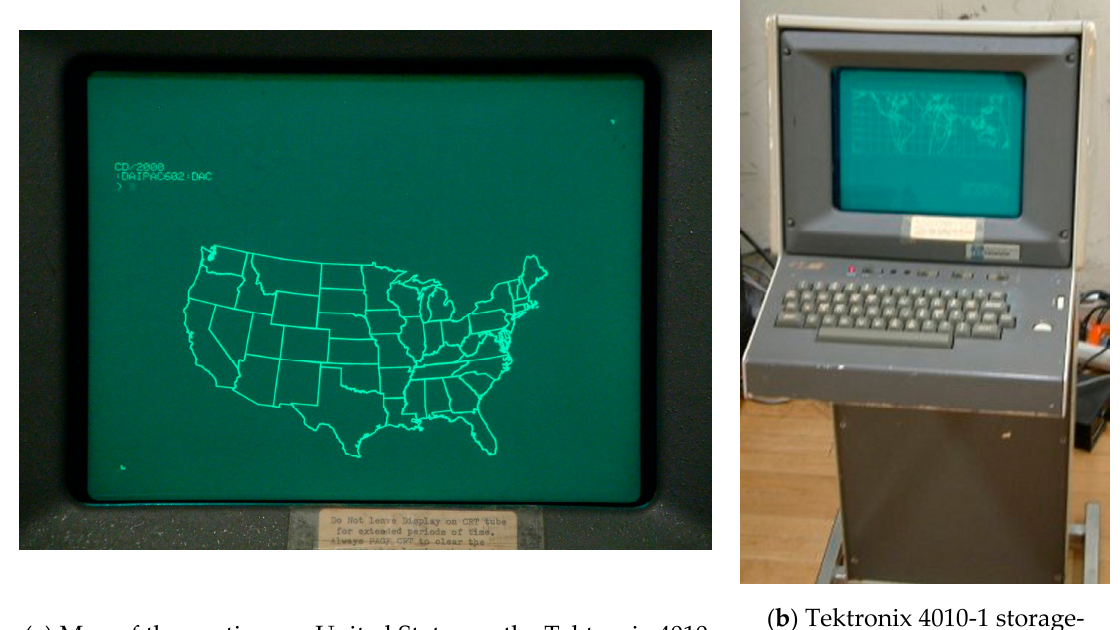
Figure 1. Example of user interfaces for GIS before GUIs. ( a ) (Reprinted from [7] with permission from David Gesswein/GNUplot); ( b ) (Reprinted from [8] with permission from David Gesswein).